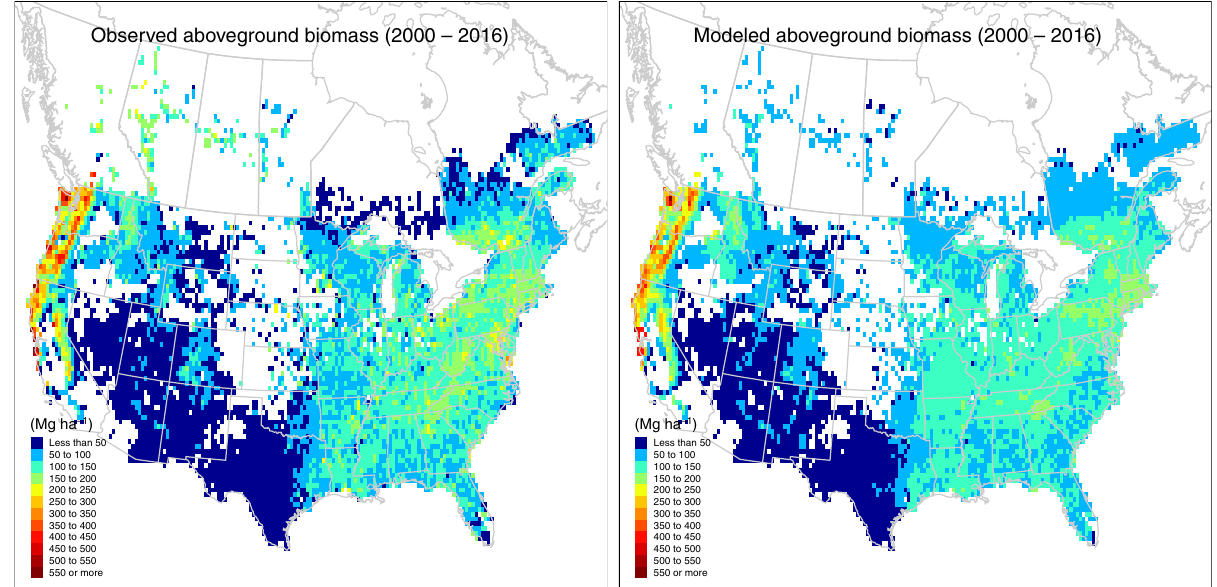
Fig. 2 Geographic distributions of current forest aboveground biomass. Both the observed and modeled maps are averaged at the 10-min longitude by latitude resolution from inventory plots for the current period, 2000 – 2016. GIS data source: GADM database of Global Administrative Areas